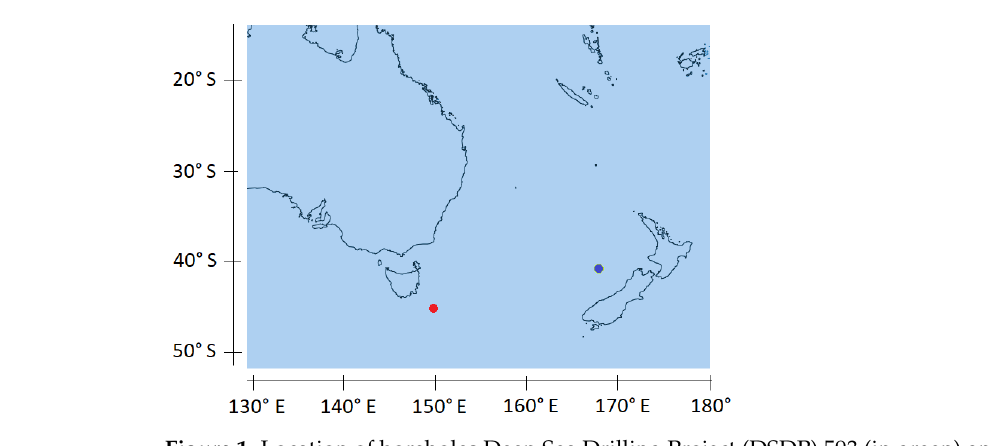
Figure 1. Location of boreholes Deep Sea Drilling Project (DSDP) 593 (in green) and ODP 1172 (in red) in the Tasman Sea.